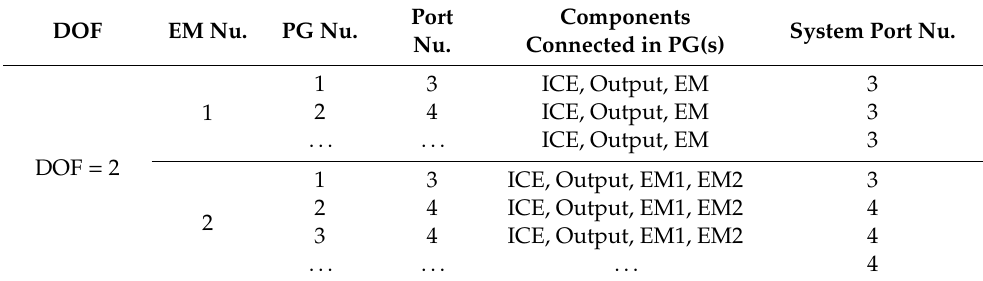
Table 2. Feasible connections in the two degrees of freedom planetary hybrid powertrain system.